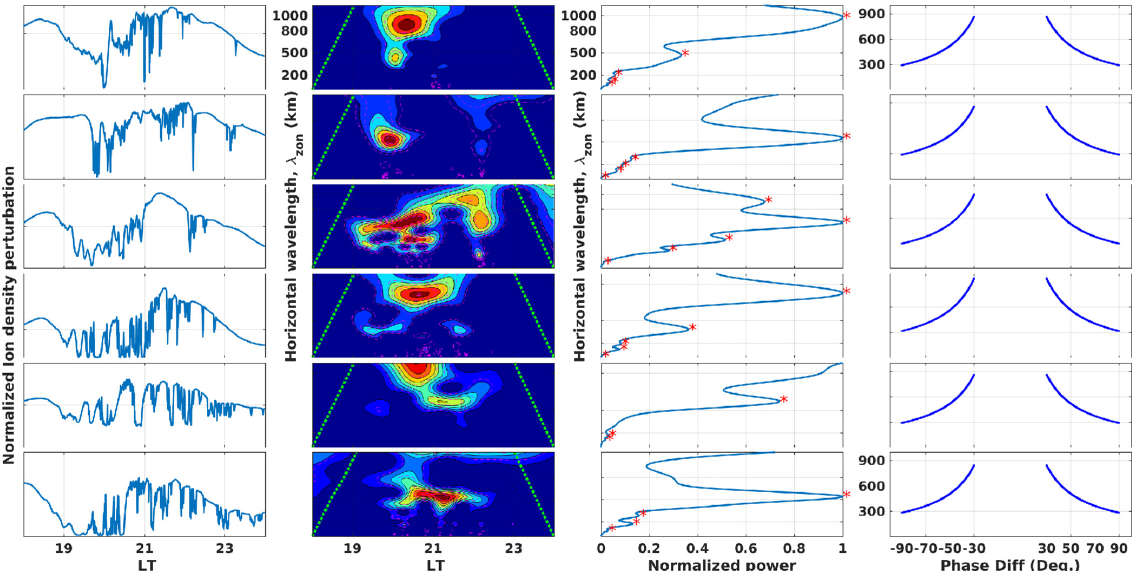
Figure 11. Normalized ion density perturbation ( left panels ) versus LT, contour map of wavelet power of normalized ion density fluctuations versus zonal wavelength and LT ( 2nd column from the left , deep red and blue colors represent dominant and weak power, 95% confidence intervals are represented by magenta color dashed line curves) and time integrated normalized wavelet power of normalized ion density fluctuations versus zonal wavelength ( 3rd column from the left ), and gravity wave zonal wavelength versus phase shift ( 4th column from the left ) on 15 October 2011. The asterisks in the third column represent peak value of time integrated normalized wavelet power.